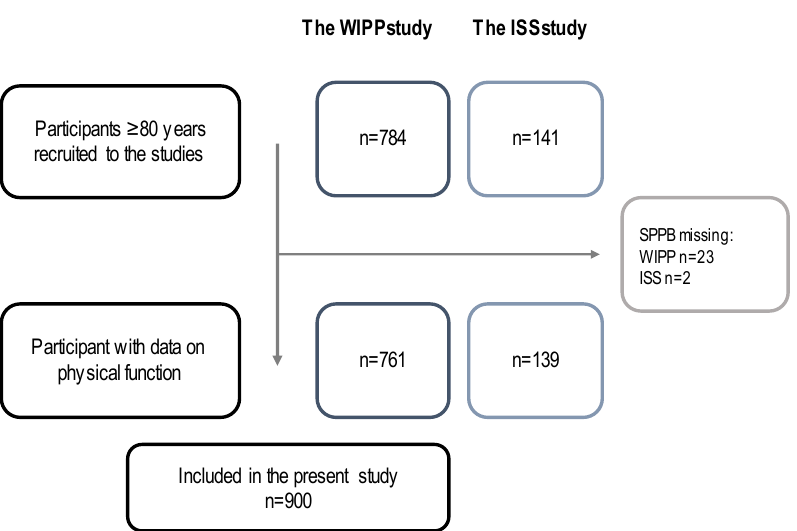
Figure 1. Participant Flow Chart. WIPP—Welfare Innovation in Primary Prevention, ISS—I’m Still Standing, SPPB—Short Physical Performance Battery. Table 1. Characteristics of study